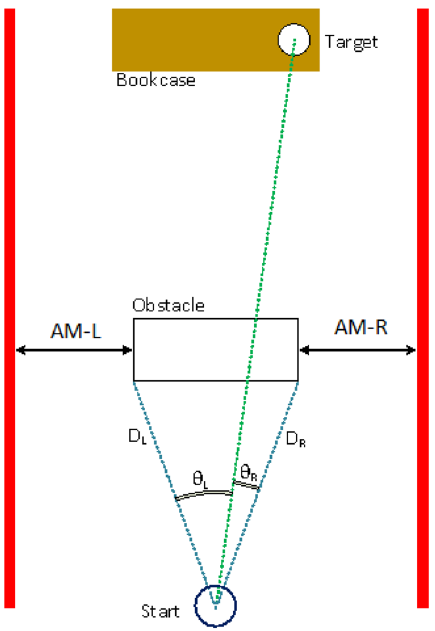
Figure 2. Experimental setup. Participants walked to a bookcase that had an empty 16 oz cup (the “target”) sitting in its lower shelf (.88 m from the floor). AM-L represents the left avoidance margin; AM-R represents the right avoidance margin; D L and D R correspond to the distance from the center of the starting position to the left and right edges of the obstacle, respectively. θ L is the left deviation angle and is the angle between the straight line connecting the target and the center of the starting position and the line connecting the outer left edge of the obstacle relative to the starting position. θ R represents the right deviation angle and is defined as the angle between the straight line connecting the target from the center of the starting position and the line connecting the outer right edge of the obstacle relative to the center of the starting